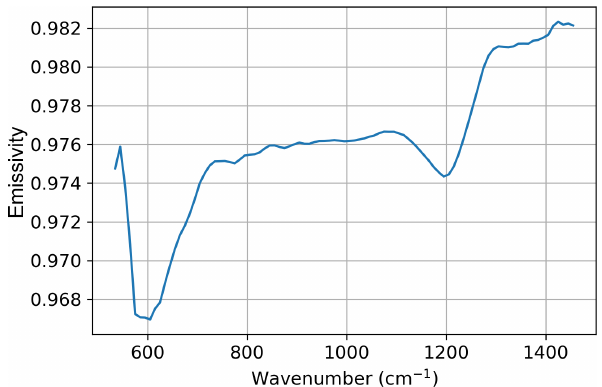
Figure 3. Smoothed spectral emissivity of the blackbody